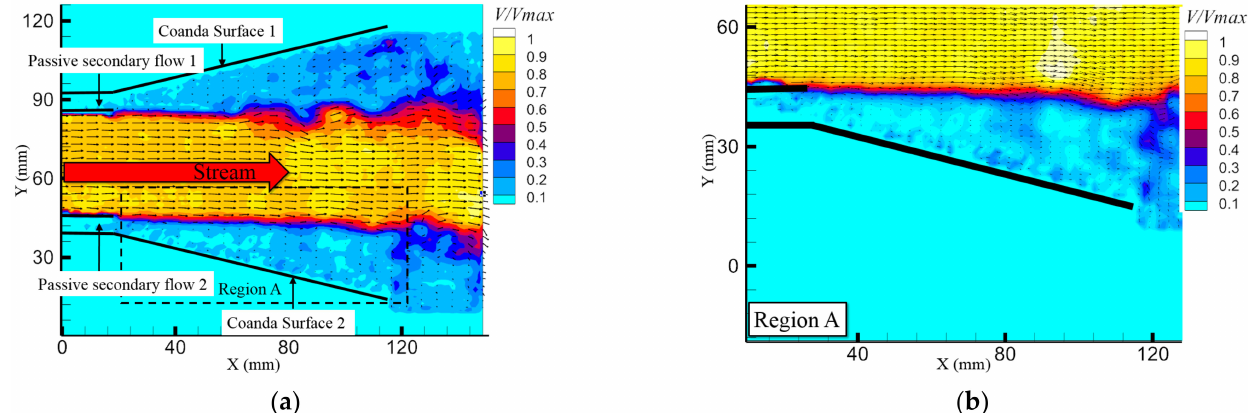
Figure 8. Detachment condition PIV visualization. ( a ) Velocity vector and velocity nephogram of the whole flow field under the jet detachment condition; ( b ) velocity vector and velocity nephogram of the Region A under the jet detachment